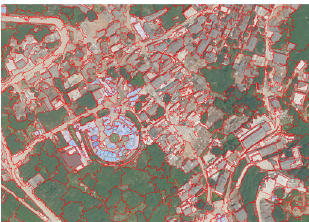
Figure 4. The Multi-scale segmentation of remote sensing